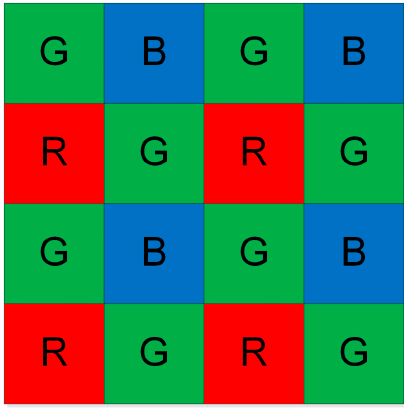
Figure 1. Bayer pattern of GBRG mode.